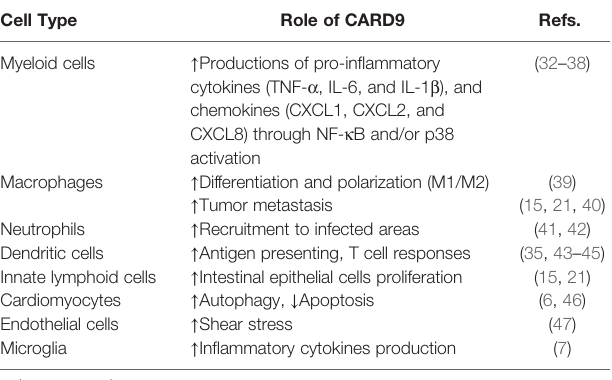
TABLE 1 | The role of CARD9 in different